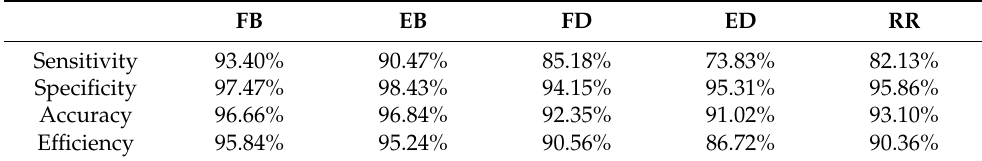
Table 13. Classifier performance parameters for the validation stage.